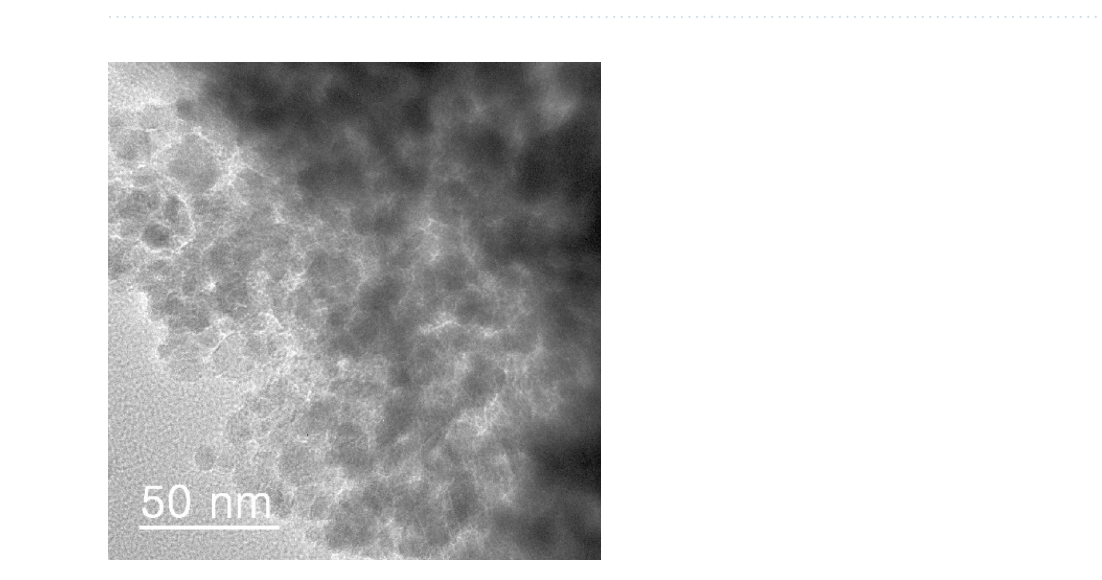
Scheme 3. Proposed mechanism for the synthesis of tetrazoles.